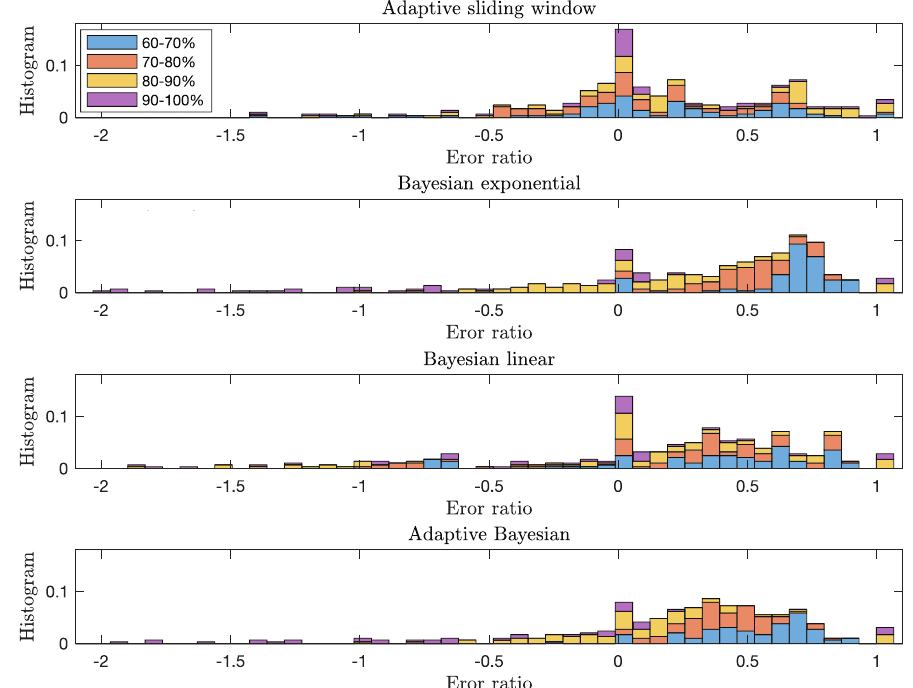
Figure 7. Normalized error ratio histogram of the RUL prediction of adaptive sliding window method, Bayesian methods using the exponential and the linear degradation models, and adaptive Bayesian method as a function of the experimental time. We split the error ratio of different solutions in each interval of 10% based on the time sequences with respect to the entire experimental time to analyze the performance of the RUL prediction over